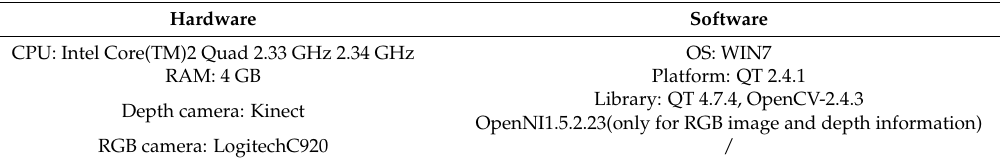
Table 2. Hardware and software of the proposed system.